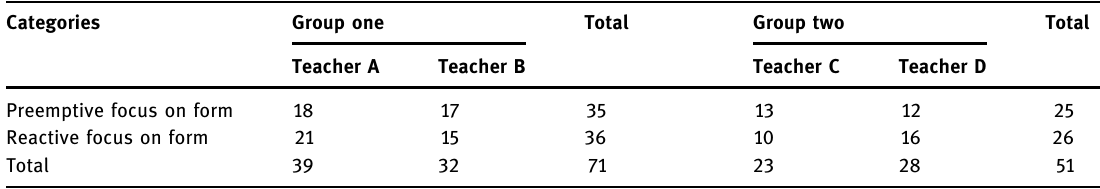
Table 1: Frequency of reactive and preemptive FFEs in two groups